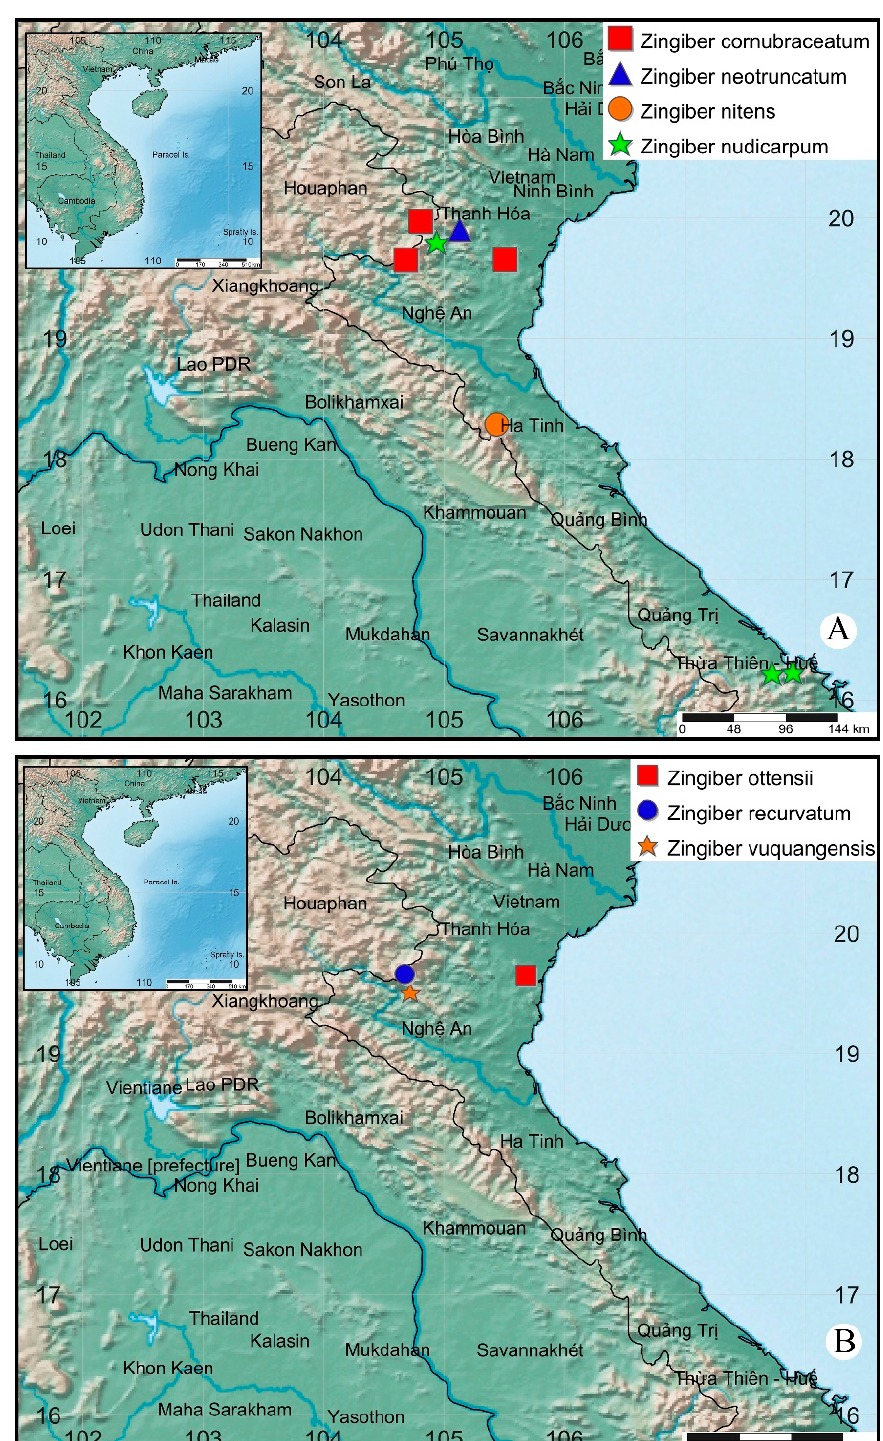
Figure 1. Distribution map of Zingiber species from the north-central Vietnam. ( A ): Zingiber cornubraceatum Triboun & K. Larsen (red squares); Z. neotruncatum Triboun & K. Larsen (blue triangle), Z. nitens M.F. Newman (orange circle), Z. nudicarpum D.Fang (green stars). ( B ): Zingiber ottensii Valeton (red square), Z. recurvatum S.Q. Tong & Y.M. Xia (blue circle), Z. vuquangensis Ly N.S., Le T.H., Trinh T.H., Nguyen V.H., Do N.D. (orange star).